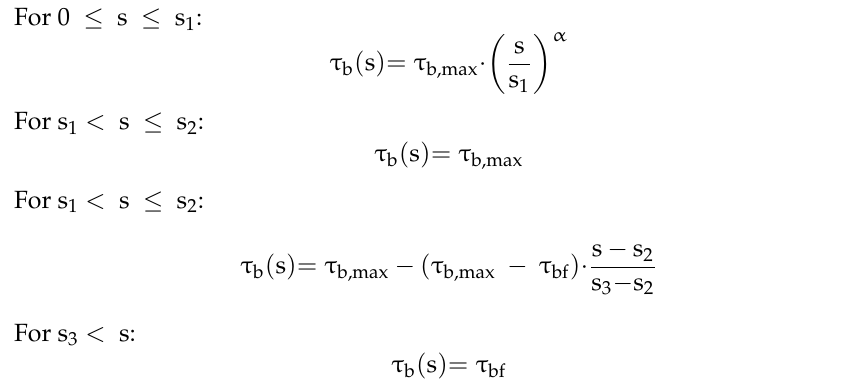
Figure 7. Analytical bond stress-slip relationship for monotonic loads acc. MC2010 [4].